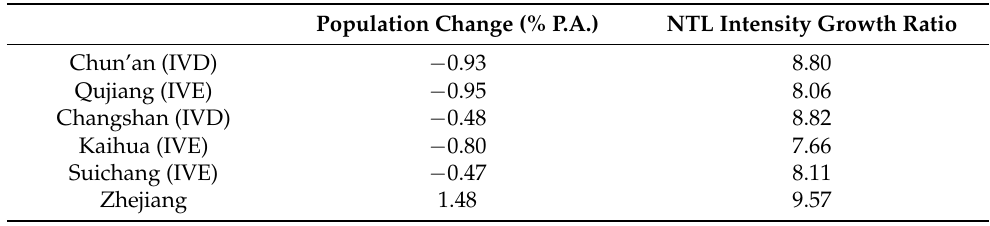
Table 3. Zhejiang Province and the shrinking county-level cities.